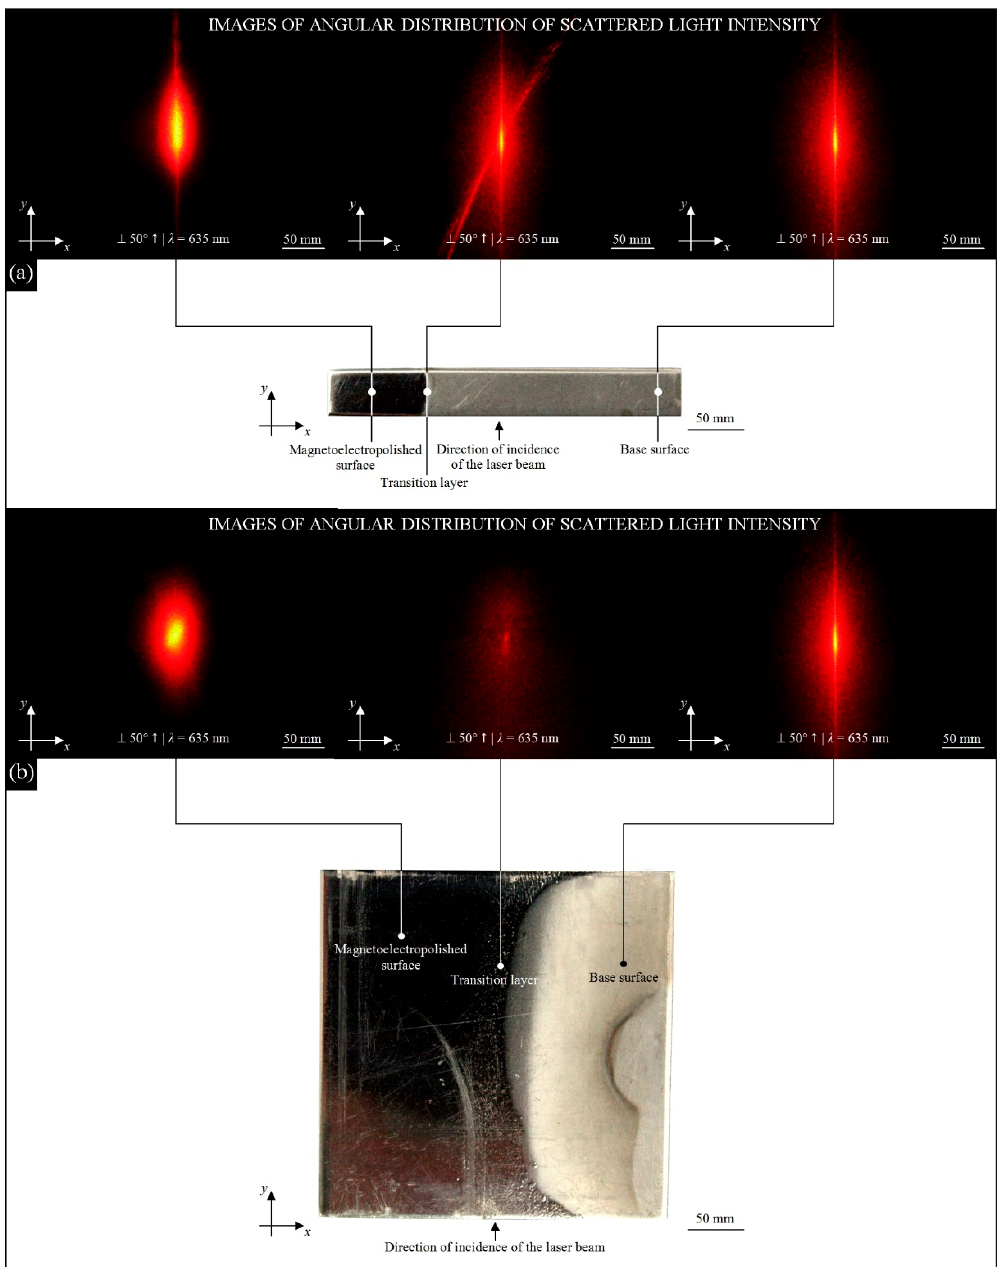
Figure 4. Collection of example results of acquisition of digital images of the angular distribution of scattered light intensity carried out for surface after the MEP process, transition layer and base surface occurring on sample: ( a ) MEP-800; ( b ) MEP-50.